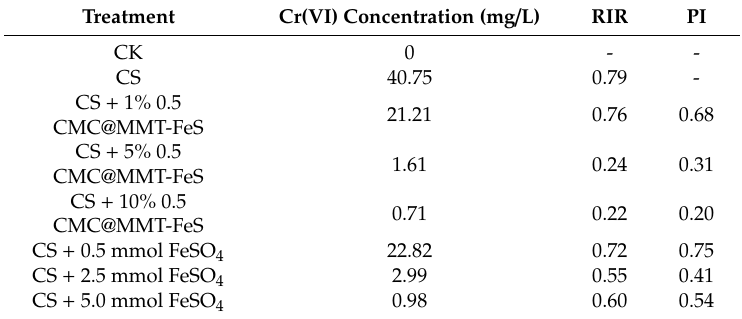
Table 1. Responses of Vicia faba to the soil Cr(VI) concentration before and after